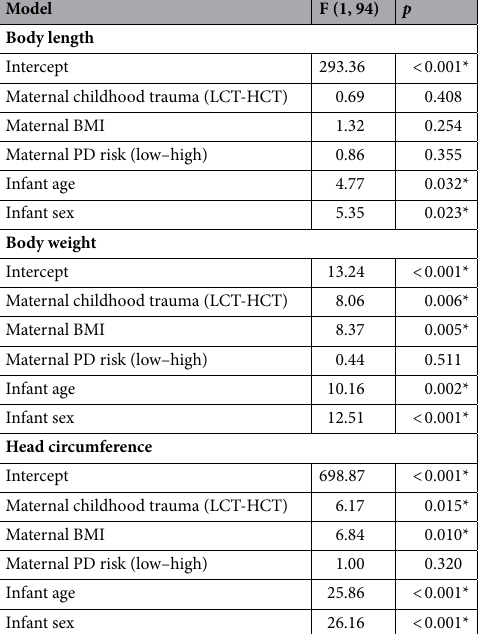
Table 4. Results of univariate analysis of MANCOVA models for body parameters at the age of 5 months. Significant effects asterisked.